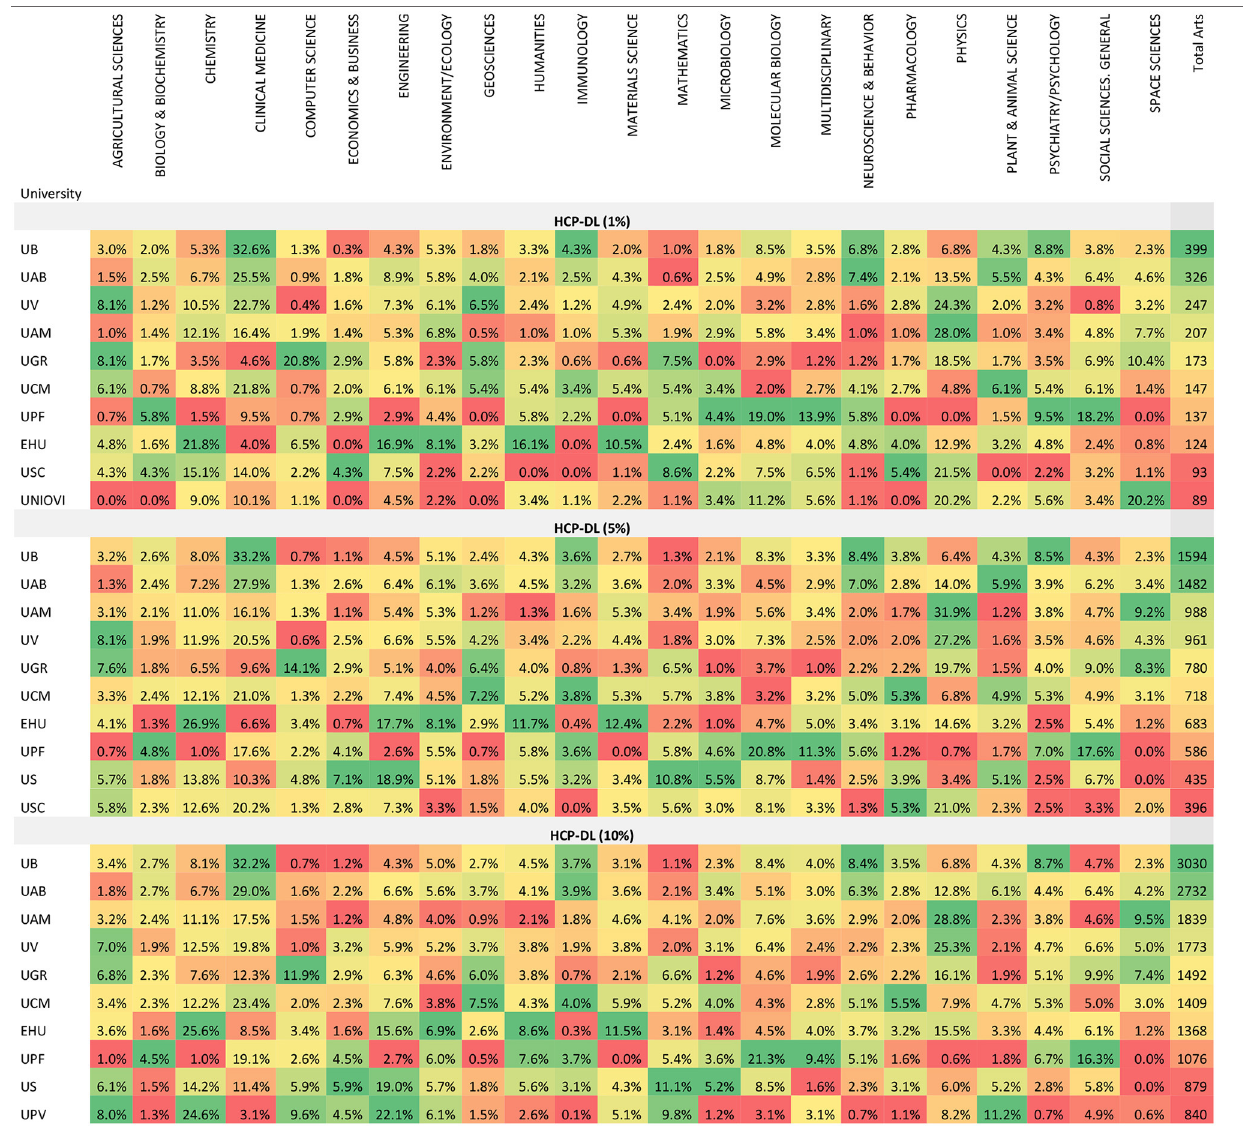
Color shades indicates the magnitude (green are universities and subject areas with higher values and red with lower